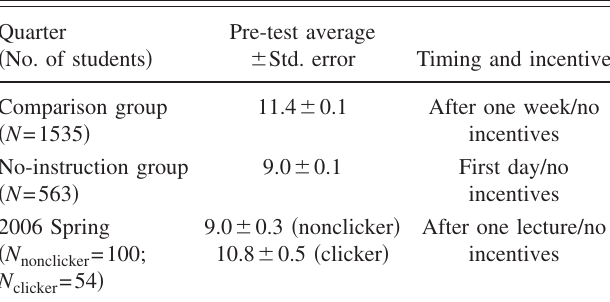
TABLE I. Pre-test conditions and results.